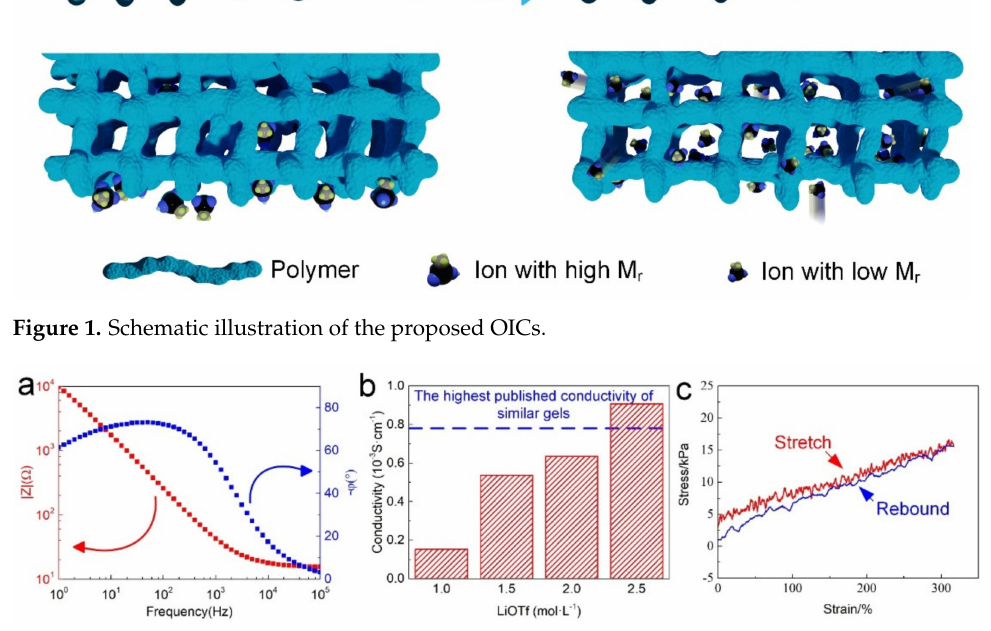
Figure 2. The electrical and mechanical properties of OICs: ( a ) frequency response of impedance magnitude (|Z|) and phase angle ( ϕ ), ( b ) conductivity of OICs at various LiOTf concentrations, ( c ) tensile and rebound curves of